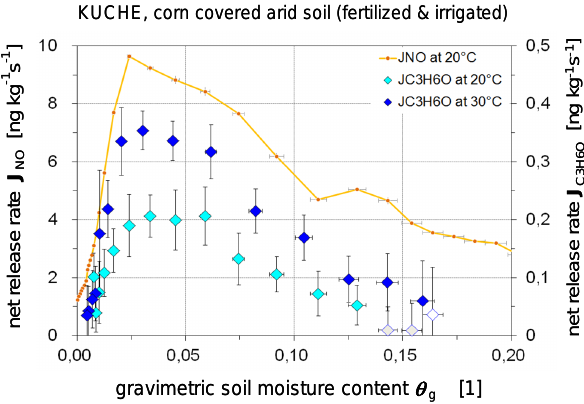
Figure 16. Net NO release rate ( T soil = 20 ◦ C) and net acetone (C 2 H 4 O) release rates ( T soil = 20 ◦ C and 30 ◦ C) at fumigation with Fig. 16: Net NO release rate ( T soil =20°C) and net acetone (C 2 H 4 O) release rates zero air of a sample taken from an arid, but agriculturally managed ( T soil = 20°C and 30°C) at fumigation with “zero”-air of a sample taken from an (fertilised and irrigated) corn covered soil in southern Xinjiang, arid, but agriculturally managed (fertilized & irrigated) corn covered soil in P. R. China. Data points marked by empty diamonds fall within southern Xinjiang, P.R. China. Data points marked by empty diamonds fall within the “deadband” of non-detectable values. Note, that net NO release rates the “deadband” of non-detectable values. Note that net NO release are expressed in terms of mass of nitrogen (N), while those of C 3 H 6 O in terms rates are expressed in terms of mass of nitrogen (N), while those of of mass of carbon (C). C 3 H 6 O in terms of mass of carbon